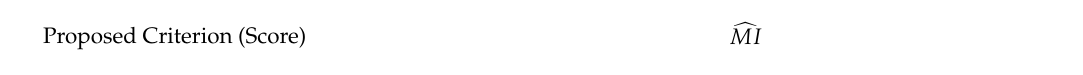
Table 2. Selected information-theoretic feature selection methods reviewed in [16,64] with potential perspectives to improve the performance using smaller bias and/or variance estimation methods. The proposed criterion uses the same notations as their original forms for readers’ ease in tracing them back to the original articles, except some terms are equivalently re-denoted as (cid:99) MI or ˆ κ to help readers follow the same notations in the previous sections. To further clarify the notations, (cid:99) MI ( X 1 , X 2 ) and (cid:99) MI ( X 1 ; X 2 ) are the same. (cid:99) MI ( X 1 , X 2 | Y ) is the plug-in estimator of conditional mutual information. By its definition, (cid:99) MI ( X 1 , X 2 | Y ) = ˆ H ( X 1 , Y ) + ˆ H ( X 2 , Y ) − ˆ H ( X 1 , X 2 , Y ) − ˆ H ( Y ) . Similarly, (cid:99) MI z ( X 1 , X 2 | Y ) = ˆ H z ( X 1 , Y ) + ˆ H z ( X 2 , Y ) − ˆ H z ( X 1 , X 2 , Y ) − ˆ H z ( Y ) , where each ˆ H z could be further replaced using ˆ H z with jackknife